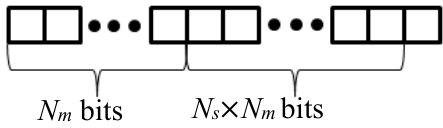
Figure 7. Code string (chromosome) for the optimization of the MSMPN subsystem.